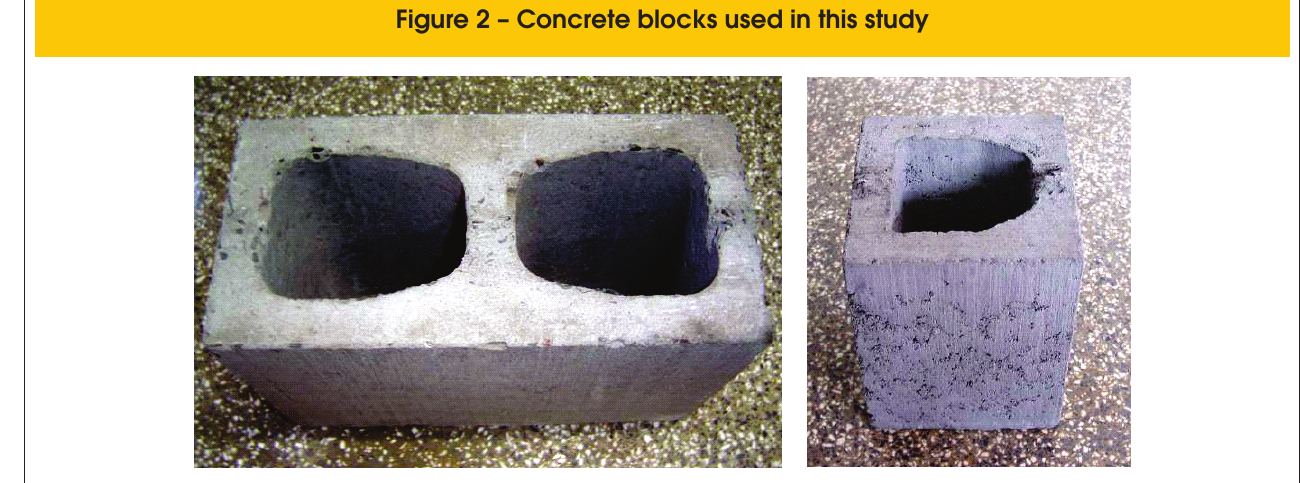
Figure 2 – Concrete blocks used in this